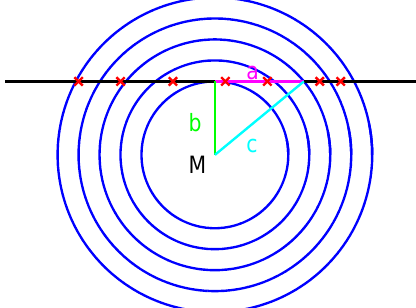
Figure 3. Scheme of the altitude and latitude grid (2D projection) and the line of sight and line from Sun. Each grid element has a different line from Sun and absorption path along the line of sight.